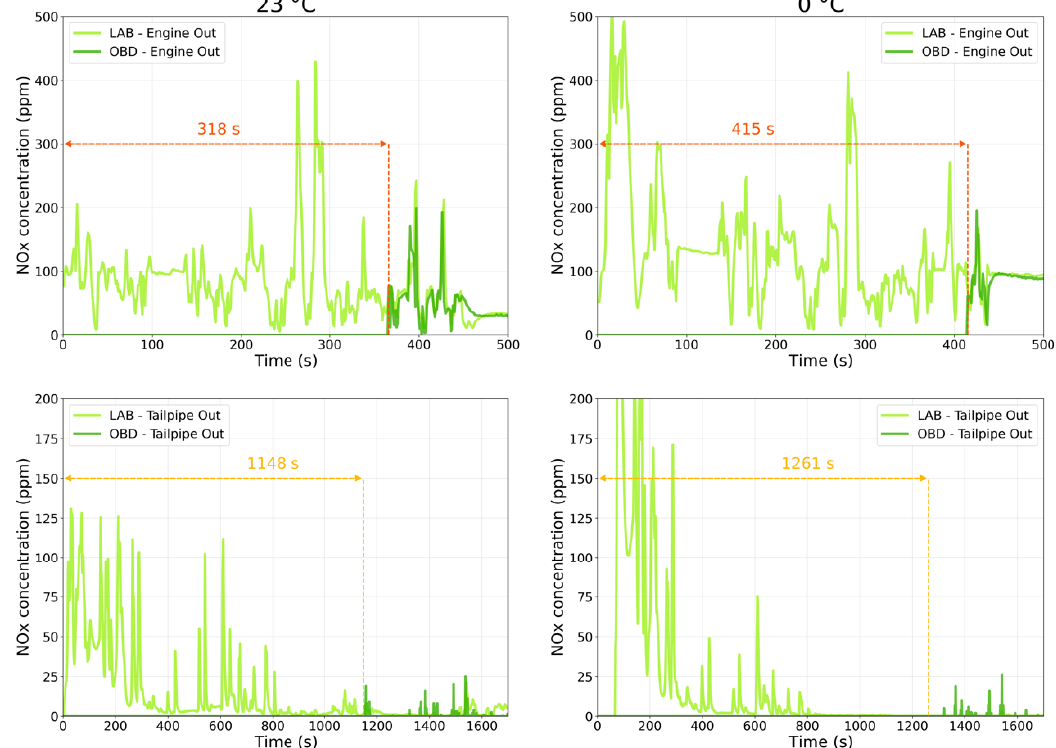
Figure 3. Top panels: engine-out NOx concentration signals from the OBD port and as measured in the laboratory (LAB) at 23 °C and 0 °C. Bottom panels: tailpipe-out NOx concentration signals from the OBD port and as measured in the laboratory (LAB) at 23 °C and 0 °C.